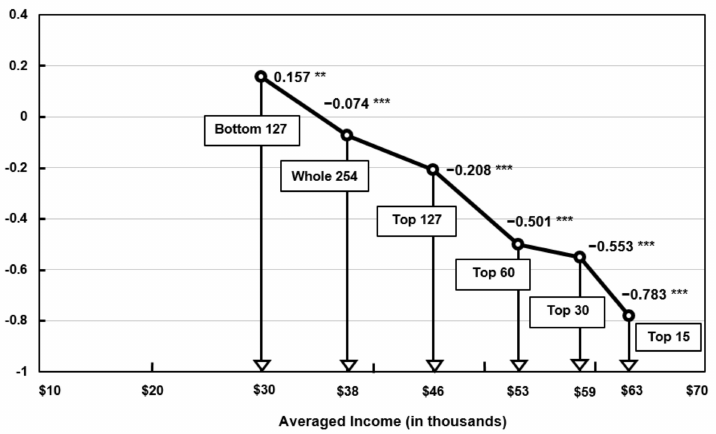
Figure 1. Distribution of income coefficients and averaged income for all cities and the five subgroups of cities (2001–2013). *** p < 0.01, ** p <